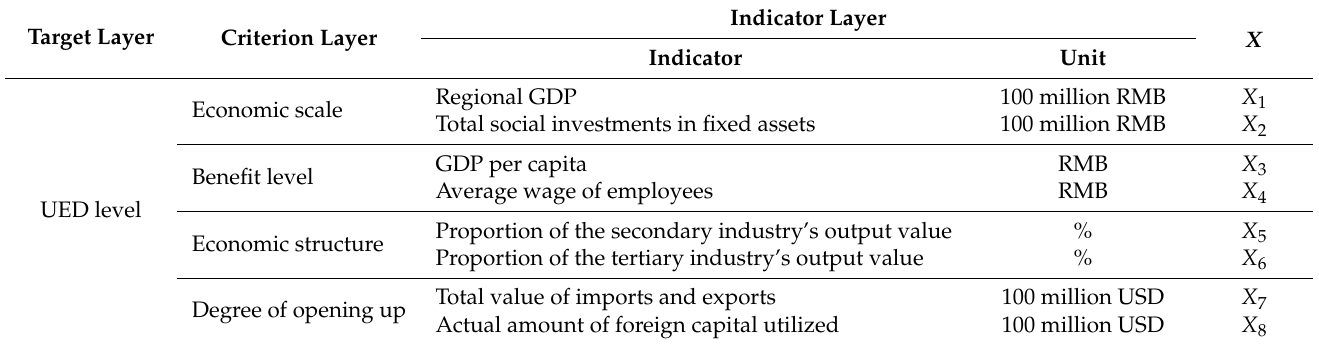
Table 1. Indicator system for evaluating port cities’ UED